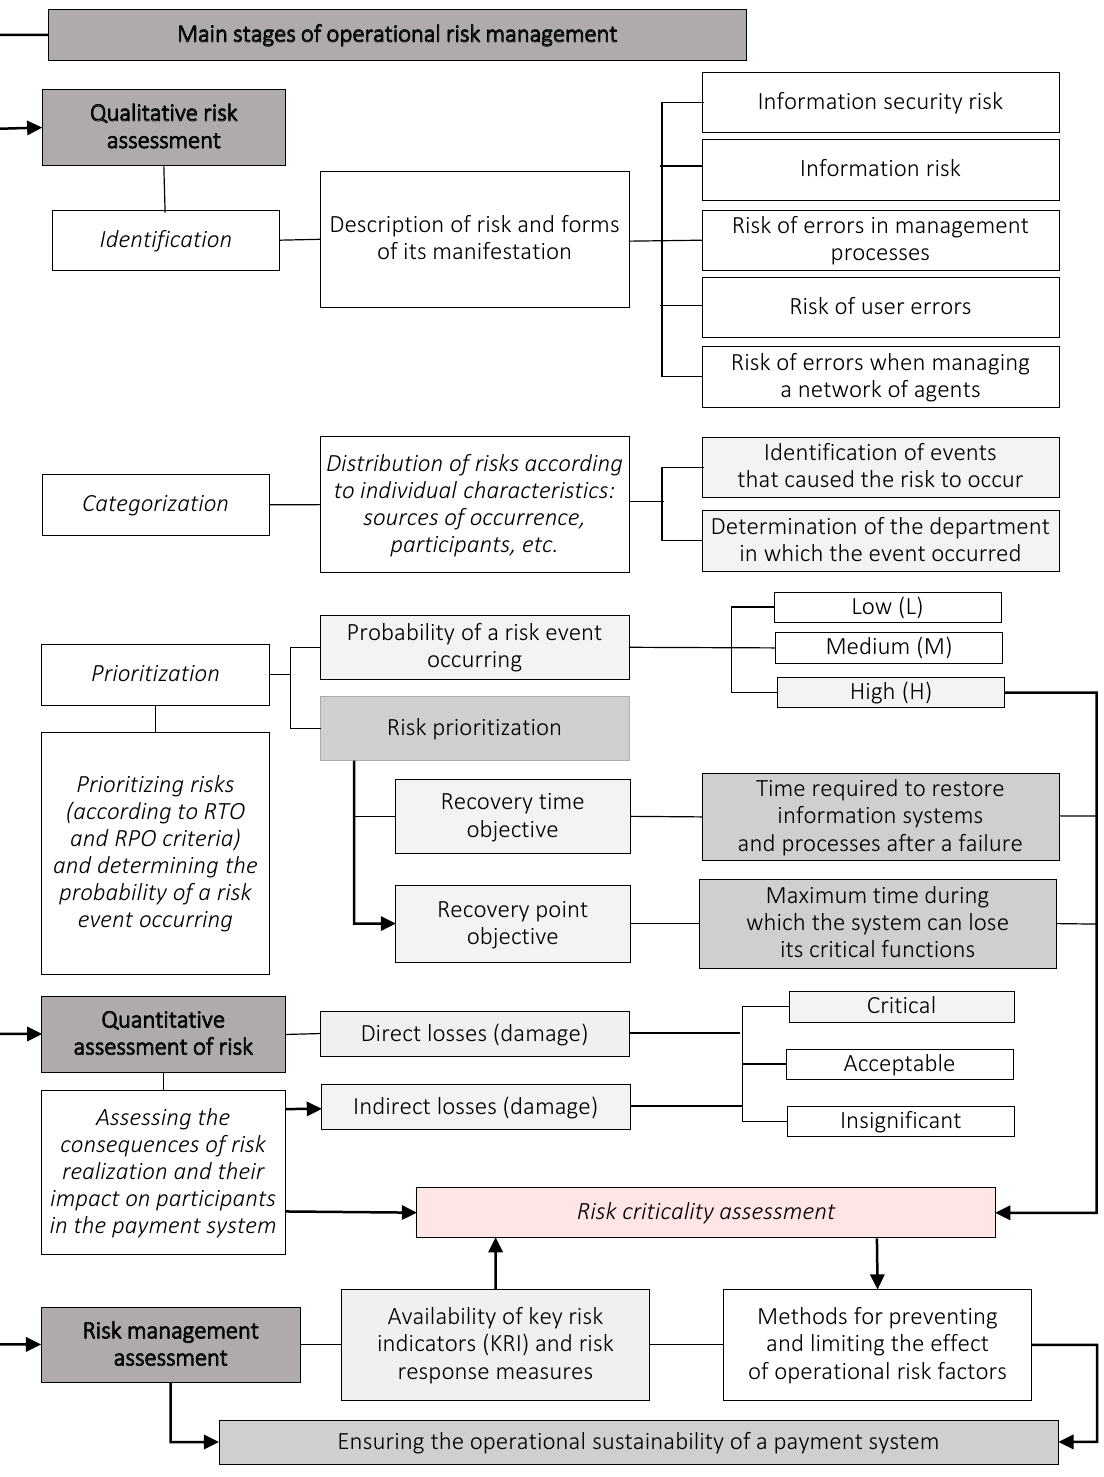
Figure A1. Key steps in assessing the operational risks of a payment system using electronic